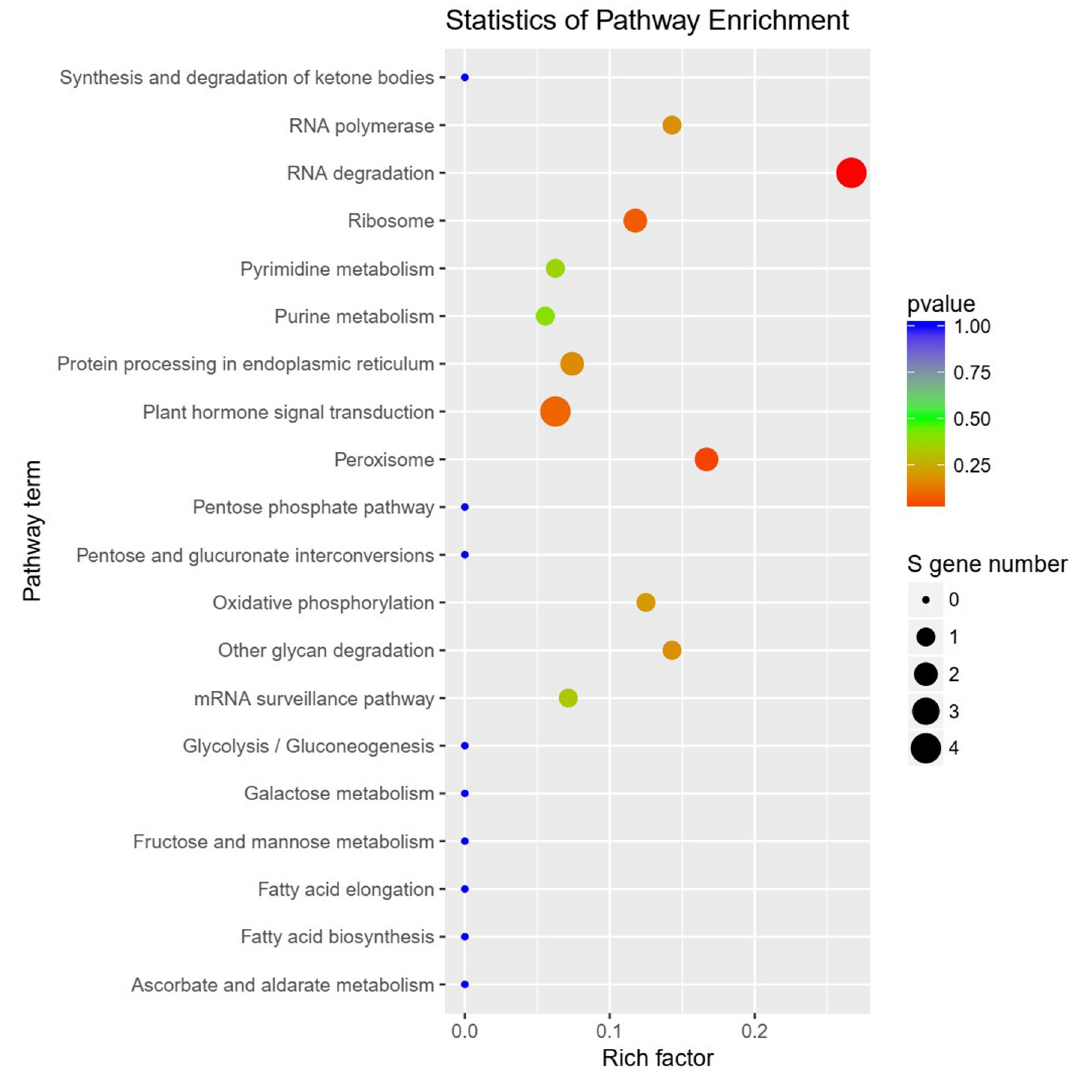
Fig 5. KEGG pathway enrichment results of different